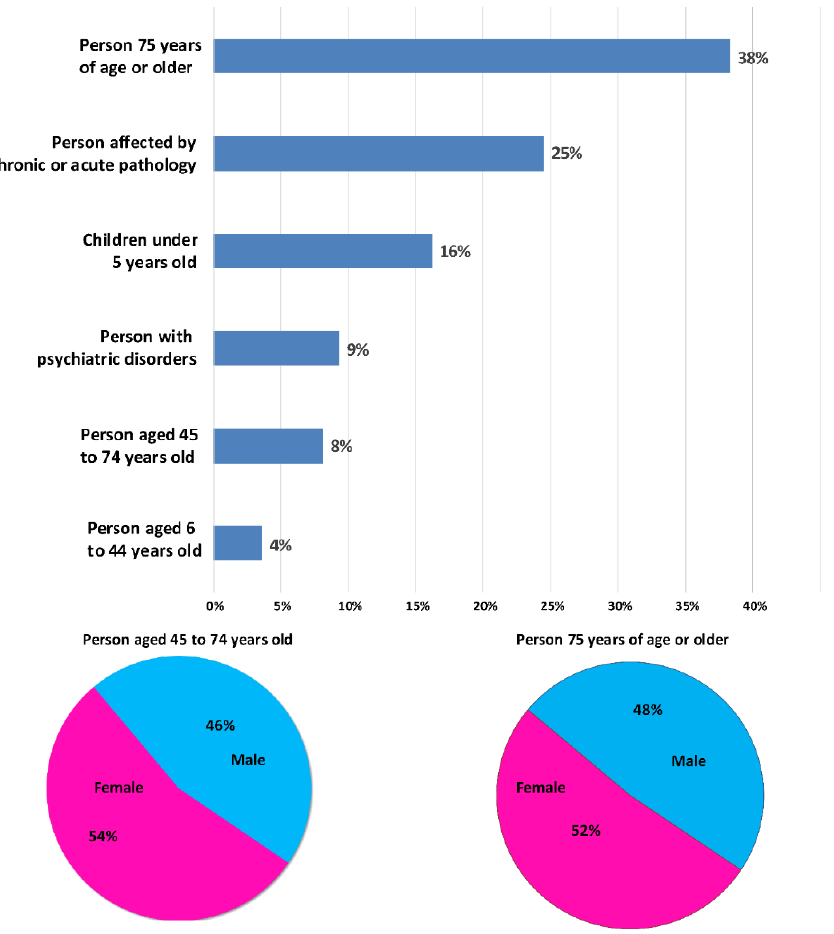
Figure 4. Relative physiological vulnerabilities for different categories of the population to heat waves.